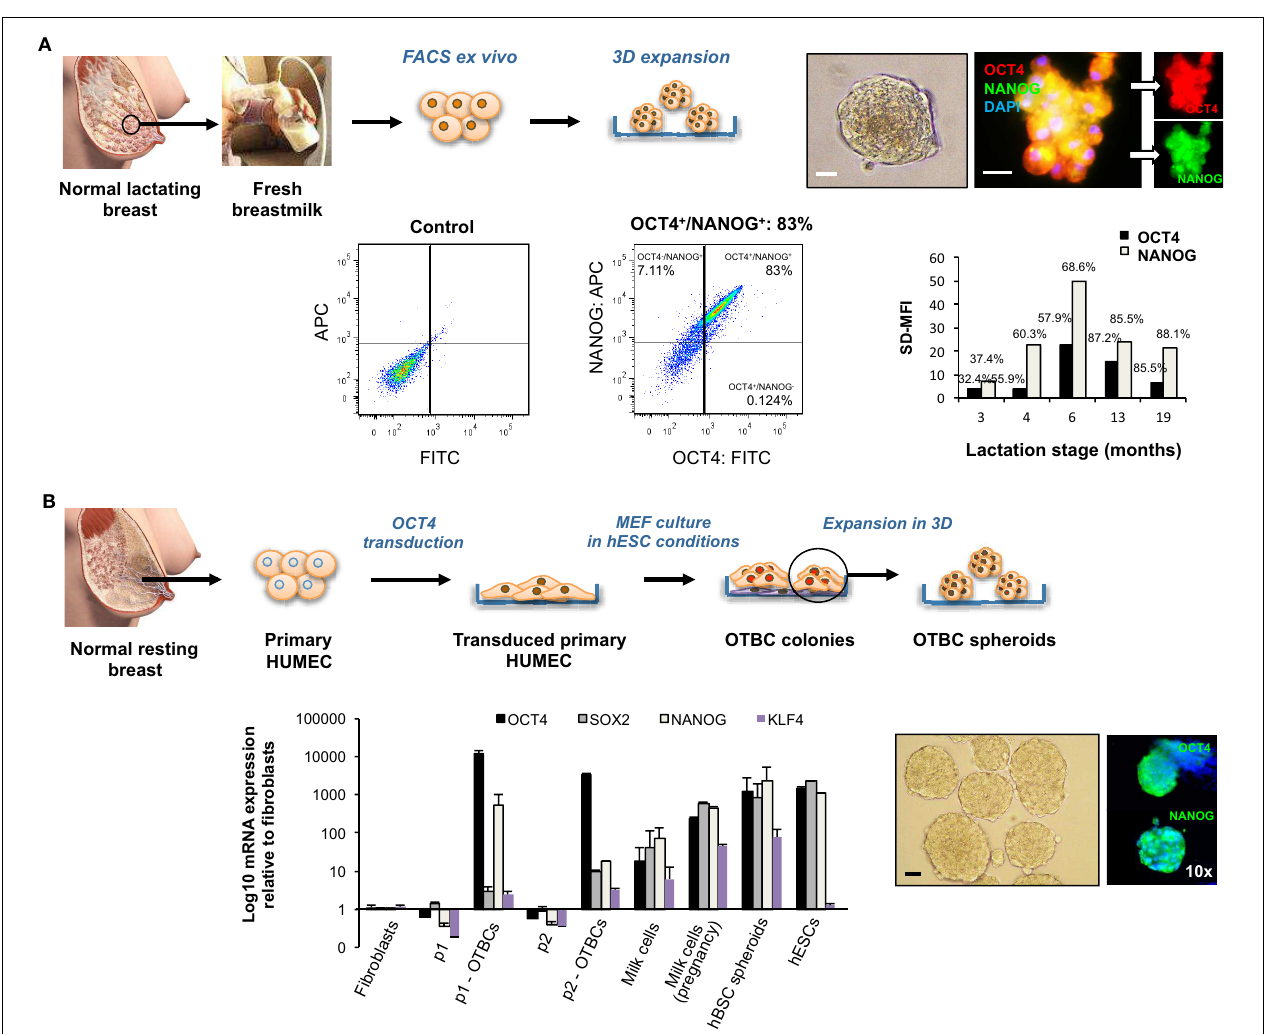
OTBC spheroids grown in 3D culture expressing OCT4 and NANOG. Blue: DAPI nuclear stain.The column chart compares mRNA expression levels of OCT4, SOX2, NANOG, and KLF4 among parental lines (p1 and p2), OTBC lines (p1-OTBCs, N = 6; and p2-OTBCs, N = 2, respectively), fresh milk cells ( N = 16), fresh milk cells during pregnancy [“Milk cells (pregnancy),” N = 1], hBSC spheroids ( N = 10–31, depending on the gene), fibroblasts, and hESCs (adapted from Beltran et al., 2011; Hassiotou et al., 2012). Individual PCR reactions were normalized against GAPDH and plotted relative to the expression level of fibroblasts. Bars represent the mean ± SEM for fibroblasts, parental lines, p2-OTBCs, milk cells-P, and hESCs, and the mean ± SD for p1-OTBCs, milk cells, and hBSC spheroids. Images of normal lactating and resting breasts: ©Medela AG, Switzerland, 2006. Used with